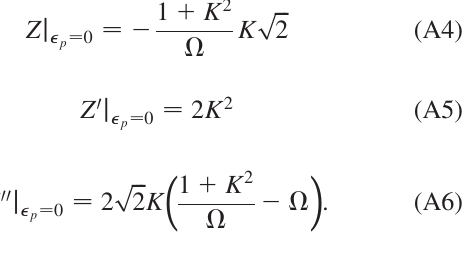
FIG. 6. Theoretical results (solid lines) versus numerical simu- lations (dashed lines) for different values of (cid:1) a normalized emittance of (cid:9) ¼ 0 (gray line), (cid:9) ¼ 0 : 1 mm mrad (red line), and (cid:9) ¼ 1 mm mrad (black line). The results of the simulations are averaged over 50 independent